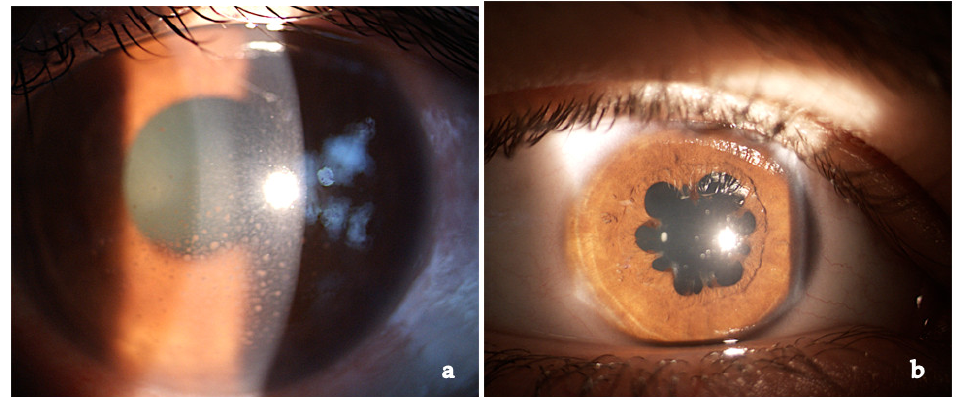
Figure 14. Typical sarcoidosic anterior granulomatous uveitis with mutton-fat keratic precipitates ( a ) and “flower-like” posterior synechiae ( b ).